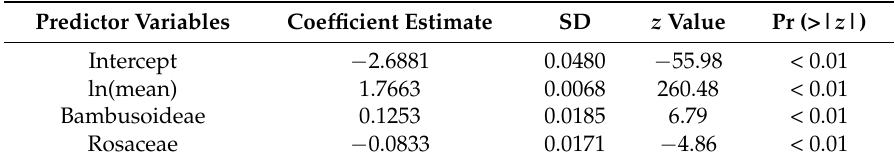
Table 1. Analysis of covariance on the significance of difference of the exponent of TPL among three classes of plants.